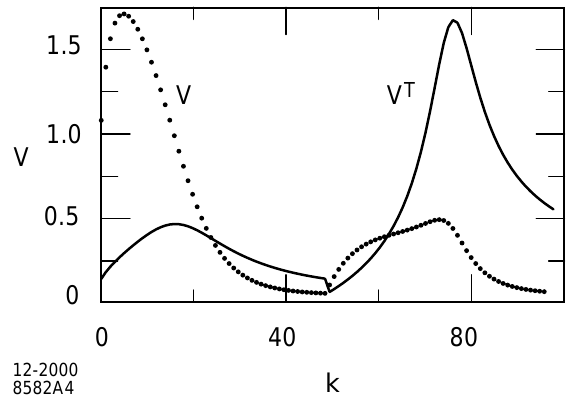
FIG. 4. Eigenvectors V (cid:1) I (cid:2) and ˆ V (cid:1) I (cid:2) , I (cid:1) 0.05 (cid:1) k 2 1 (cid:2) , of the most unstable radial mode vs k (cid:1) 1, . . . , 100 . The left part of the curves k (cid:1) 1, . . . , 50 corresponds to vector X , the right part to Y